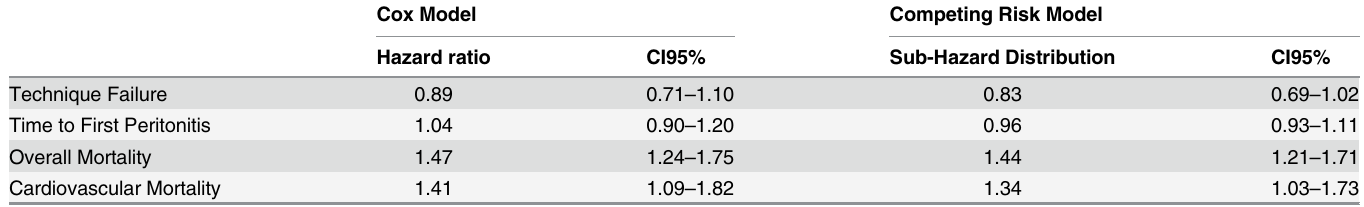
Table 2. Determinants of Clinical Outcomes taking APD as the